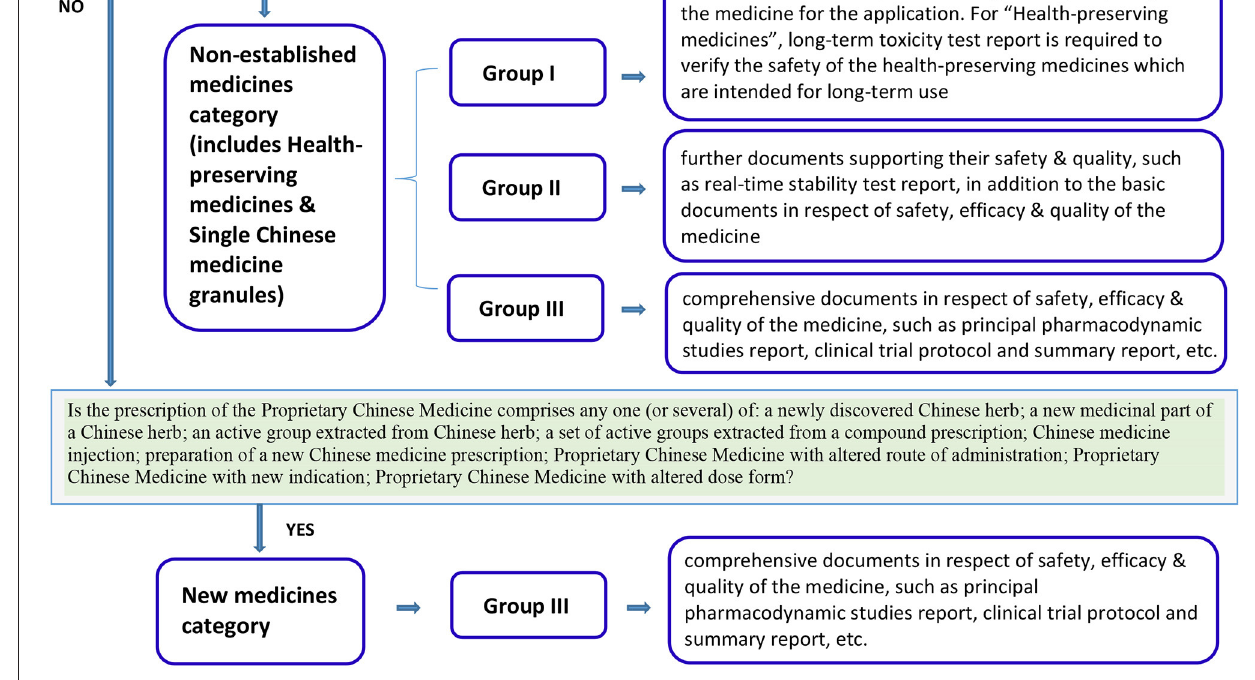
Medicines which meet the Compendial requirements may submit an application under Class I. The well-defined application guidelines help applicants to determine the right type and class of the product license for which they should apply. If in